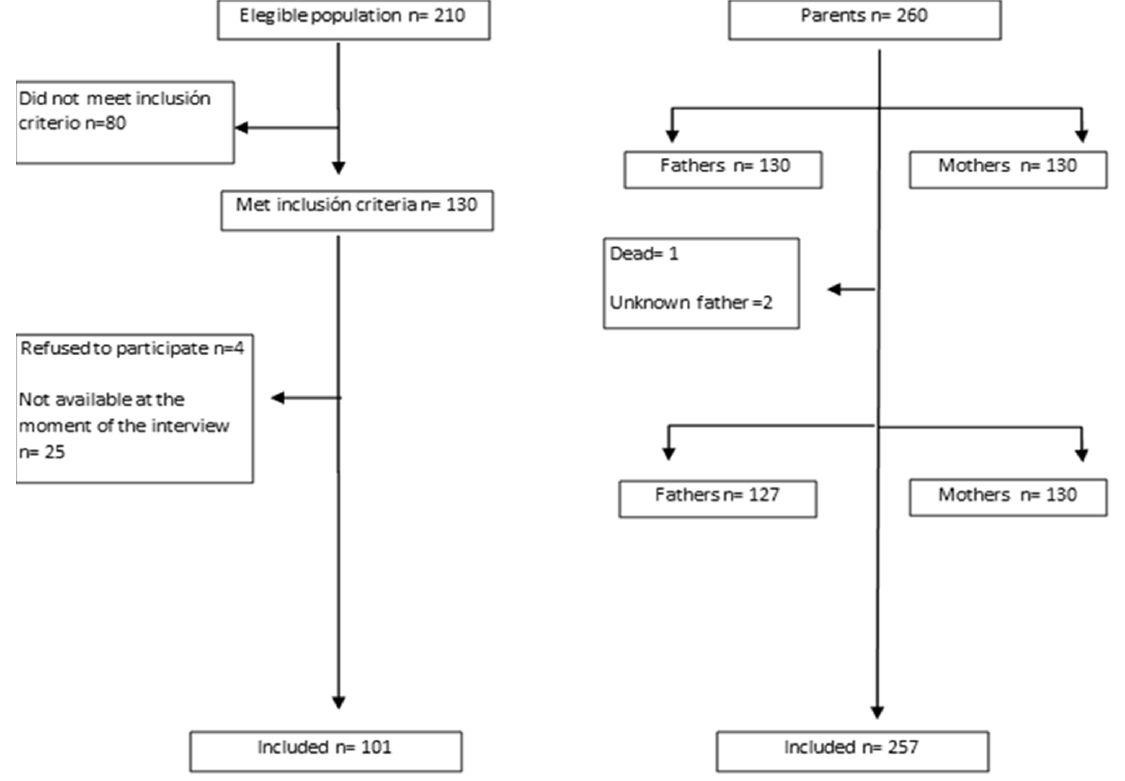
Figure 1. Participants’ flowchart.